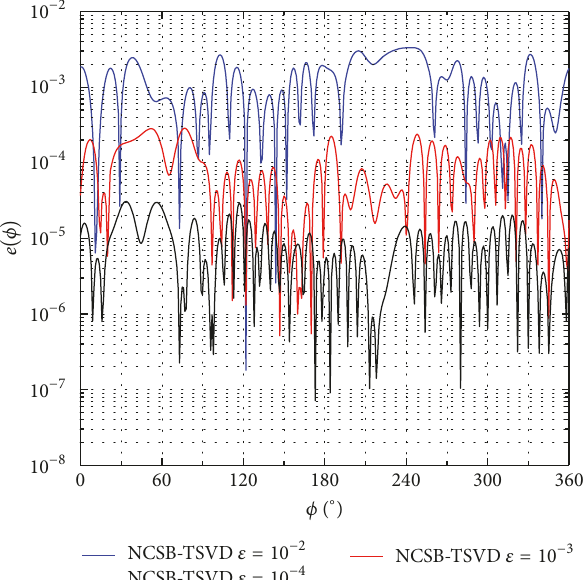
Figure 2: Relative aggregation errors measured by the radiated far field.